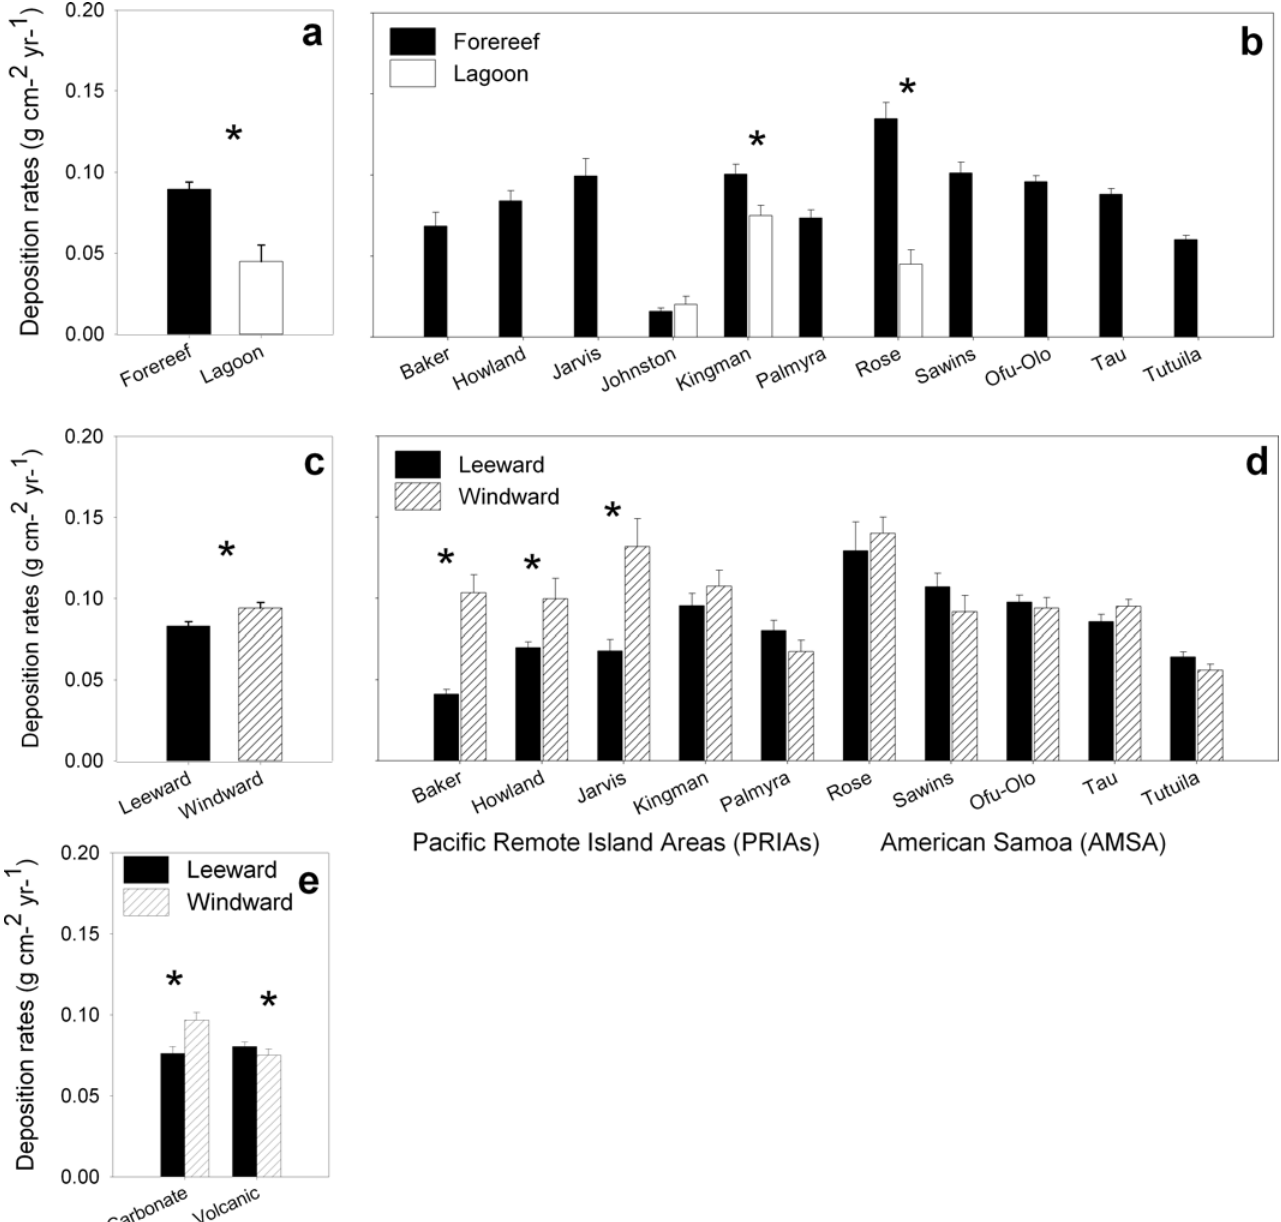
Fig 4. Graphic representation of the independent ANOVA model results illustrating the spatial variation patterns in net CaCO 3 accretion rates among island and reef zones (a, b); islands and levels of wave exposure (c, d), and island geomorphology (volcanic vs. carbonate) and wave exposure (e). Islands graphed in order of latitude; asterisks indicate significant differences among bar